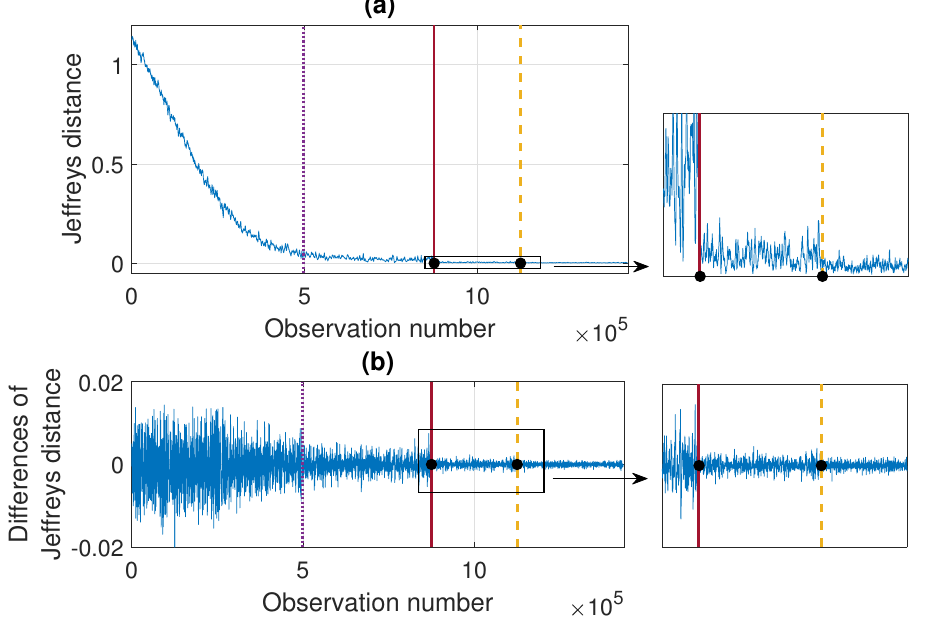
Figure 13. Jeffreys distance (panel ( a )) and differences of Jeffreys distance (panel ( b )) comparing the pdfs in the moving window of length 2500 with step equal to 250 to the the pdf corresponding to the last window. Detected regime change points are marked in purple (dotted line), red (solid line), and yellow (dashed line) and the theoretical moments of σ and α stabilization are marked with black dots.